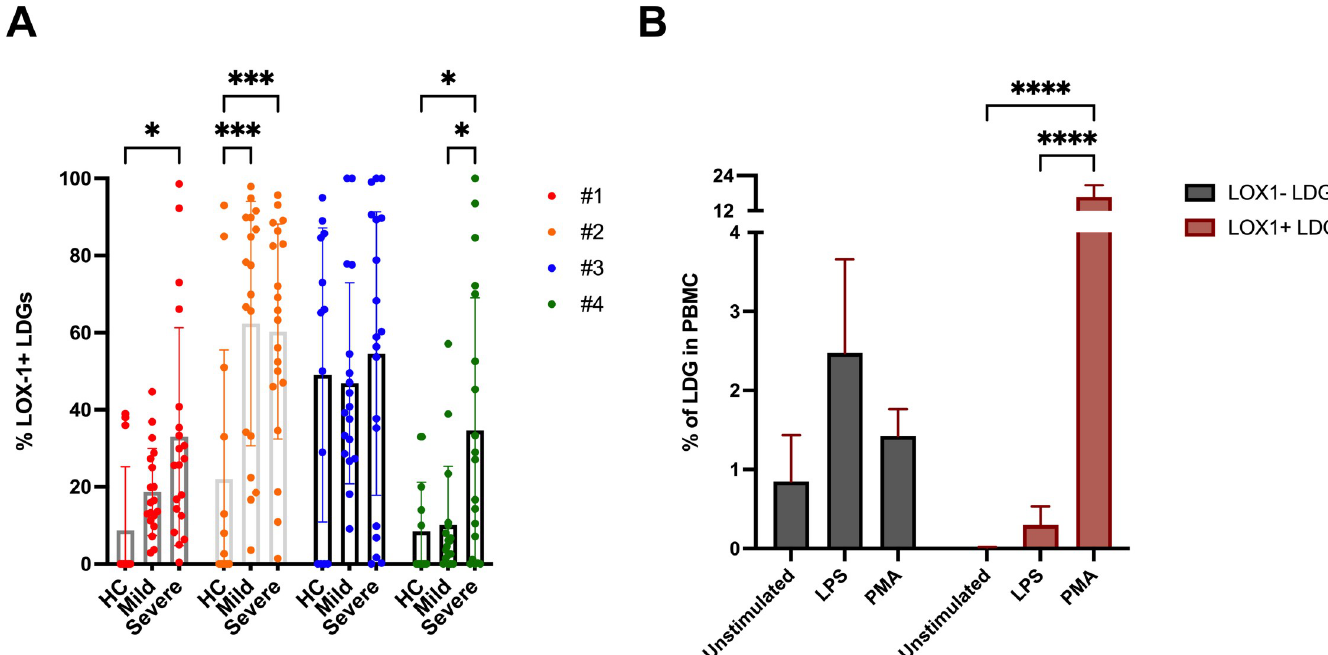
Fig 5. LOX-1+ LDGs are increased in severe COVID-19. (A) Percentage of LDG clusters #1-#4 expressing the LOX-1 surface marker in mild and severe COVID-19 as well as HC. (B) The percentage of LOX-1 + and LOX-1 - LDGs in PBMCs after 90min in vitro stimulation of whole blood with LPS or PMA (unstimulated as control). Statistically significant differences between groups indicated by � p < 0.05, �� p < 0.01, ��� p < 0.001, ���� p < 0.0001.